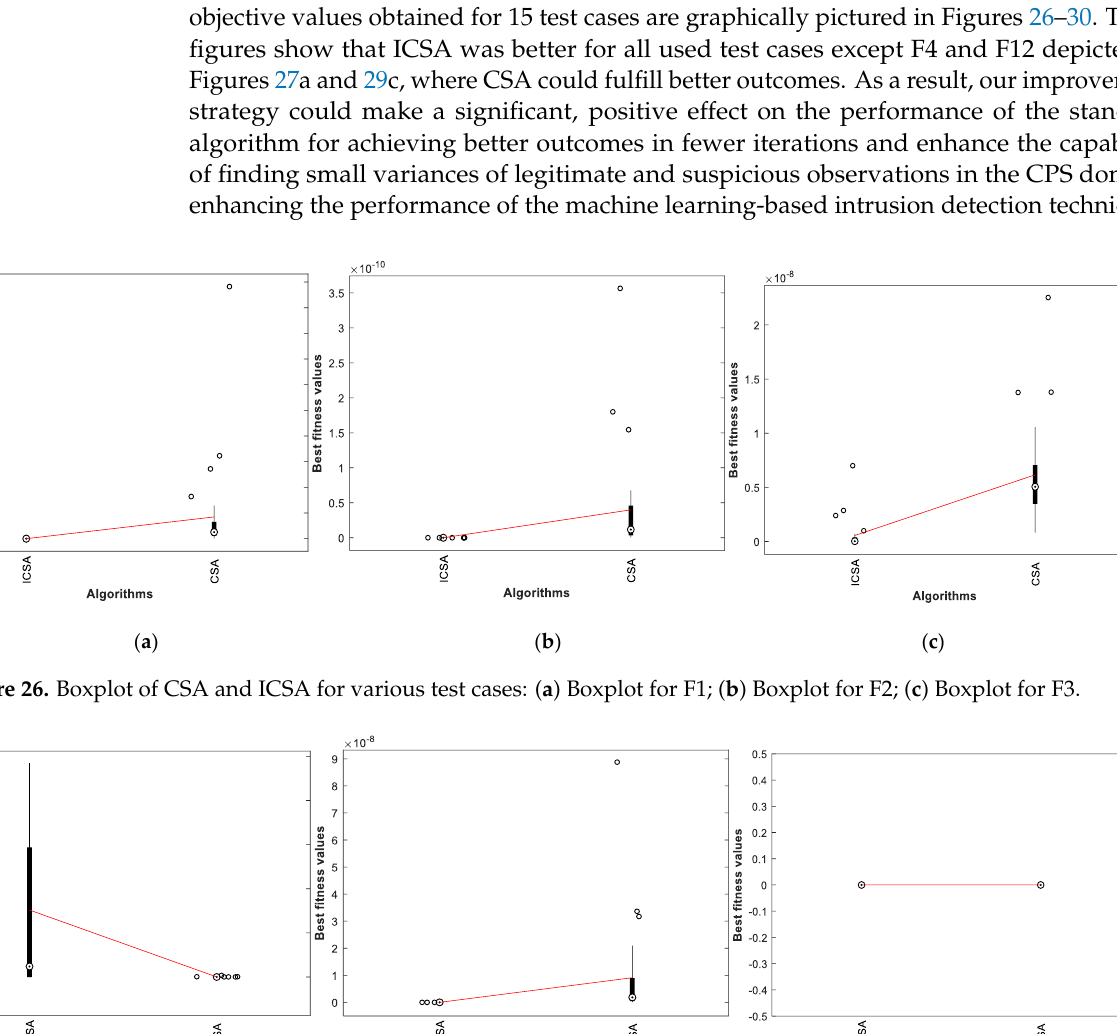
Figure 25. Comparison among algorithms in terms of CPU time.